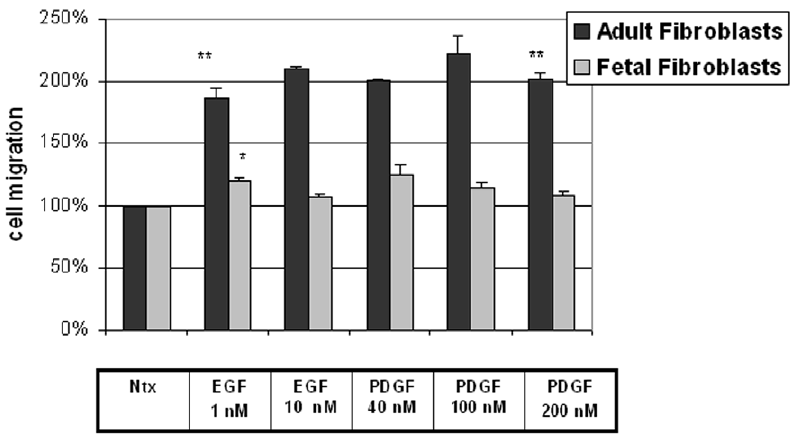
Figure 2. Cell migration of adult but not fetal fibroblasts is responsive to EGF and PDGF induction. Primary cultures of fibroblasts obtained from fetal and adult rabbit skin were tested for motility in an in vitro wound healing assay. Cells were treated with increasing concentrations of EGF (1 nM and 10 nM) and PDGF (40 nM, 100 nM, 200 nM). The values are normalized to baseline motility and shown as EGF- and PDGF-induced cell motility at each concentration. Fetal and adult fibroblasts had essentially identical baseline motility, but only adult cells responded to growth factor stimulation. The values are mean 6 SEM of six independent studies each performed in triplicate. Statistical analyses were performed by Student’s t -test.